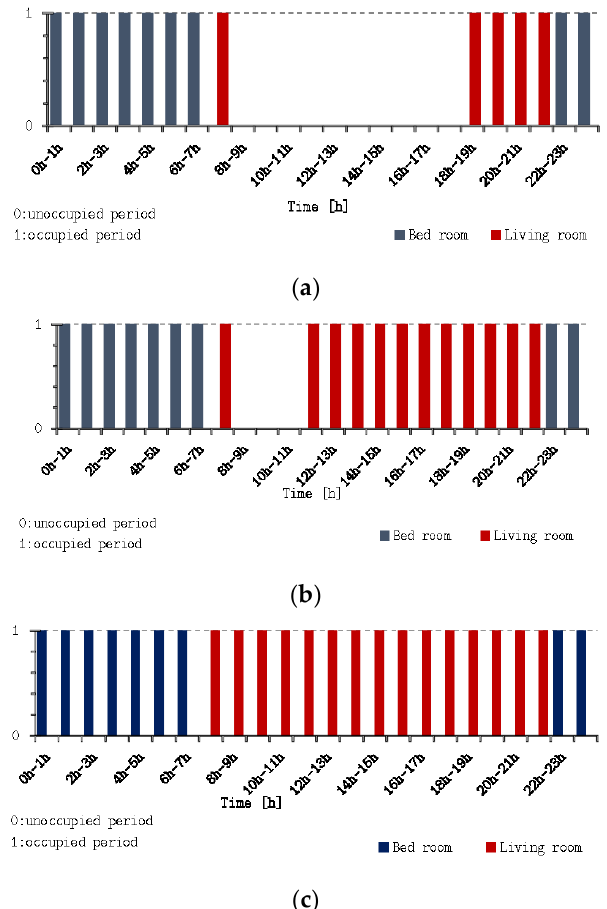
Figure 3. Occupancy schedule of the living room and bedroom of the simulated building ( a ) during weekdays, ( b ) on Saturdays and ( c ) on Sundays.